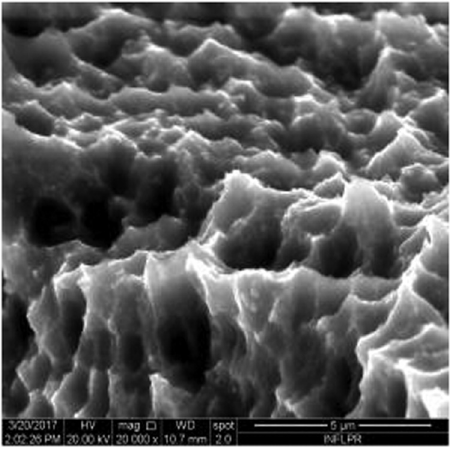
Figure 3: SEM image of sample S3 at a magni fi cation of 20k × .